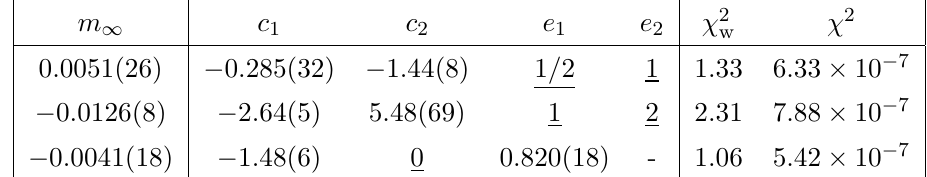
Table 4. Fit values for the (cid:12)t function given in (3.8), for three di(cid:11)erent sets of parameters. The mass m 1 represents the continuum value of the critical fermion mass m c The underlined parameters are prescribed in the 2-parameter